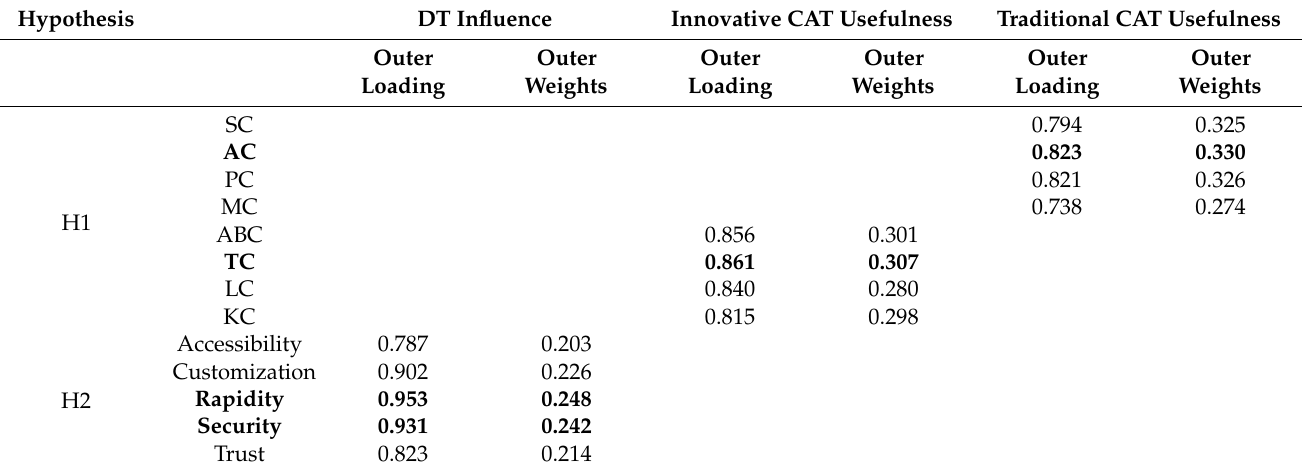
Table 5. Outer loadings and outer weights for exogenous variable.